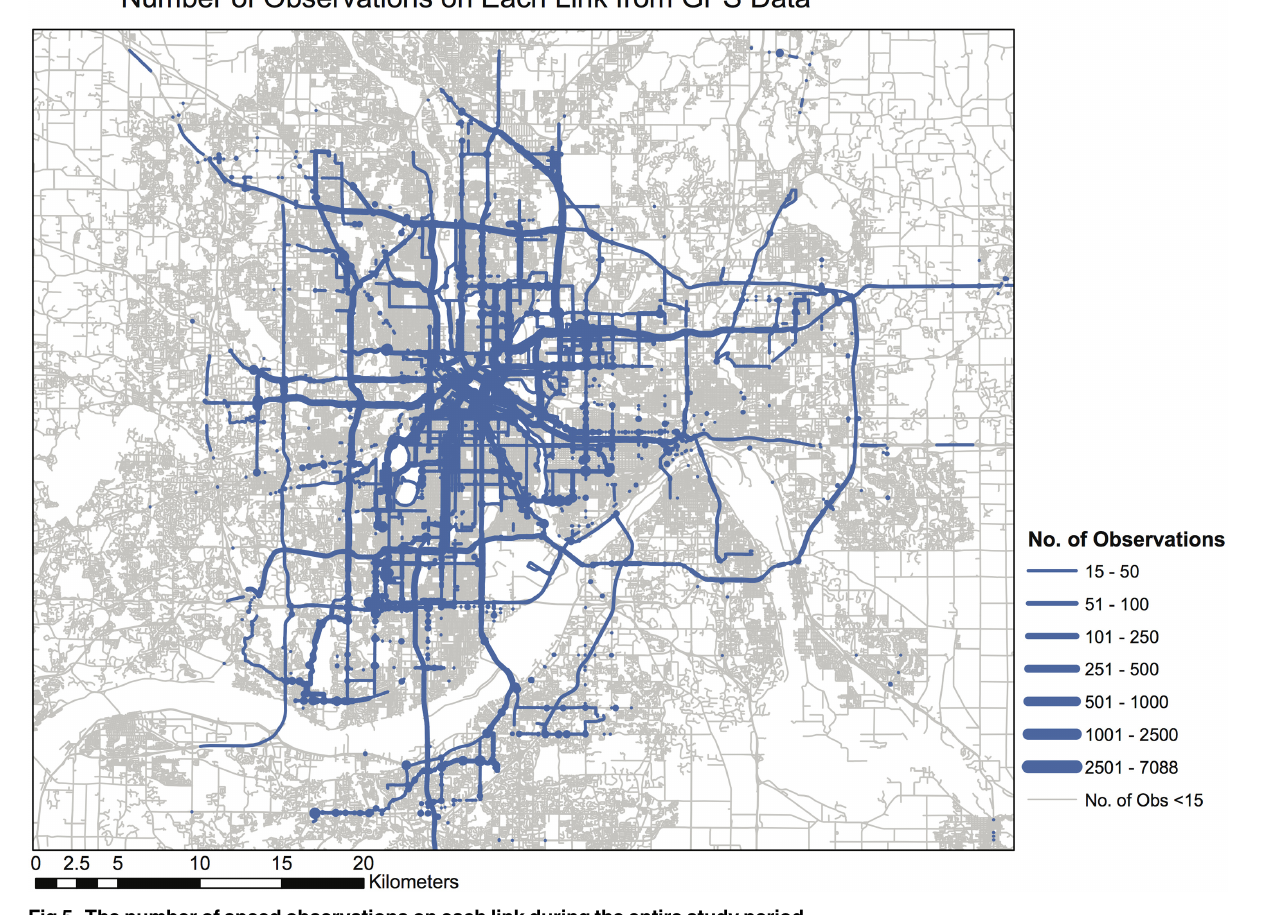
Fig 5. The number of speed observations on each link during the entire study